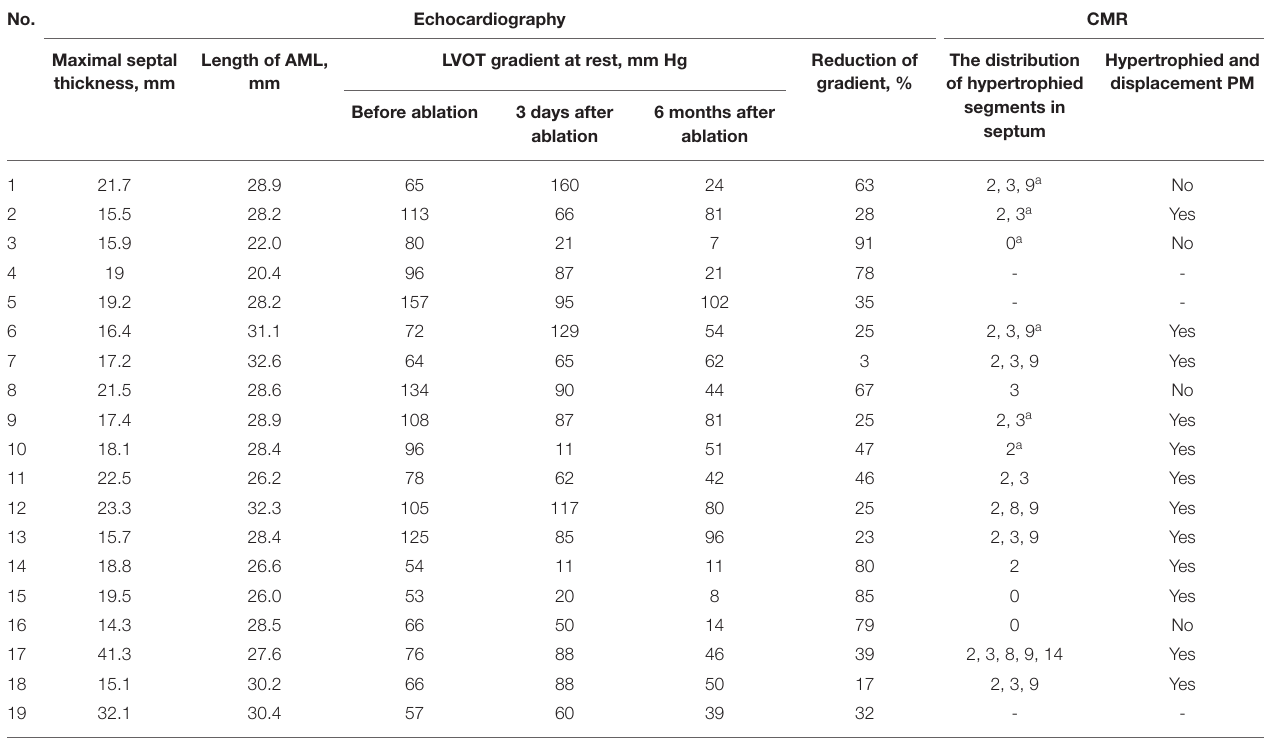
TABLE 2 | Echocardiography and CMR data in 19 patients. No.